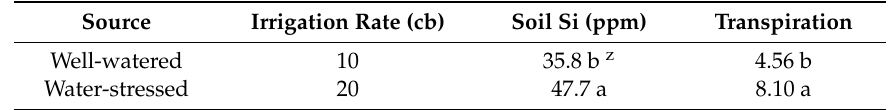
Table 10. Soil silica and transpiration of Rudbeckia hirta ‘Denver Daisy’ affected by irrigation, controlled by a tensiometer, averaged across silica